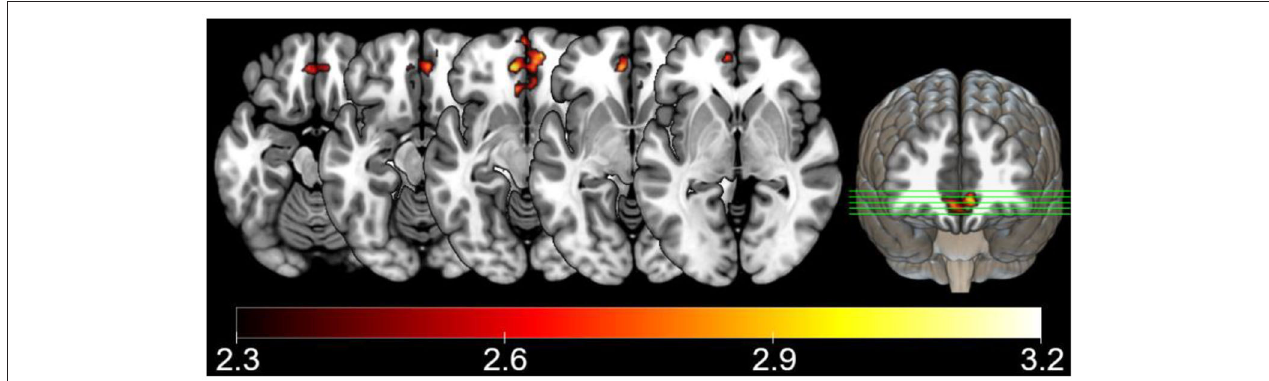
FIGURE 7 | Plots of the semantically related (SR) task block BOLD response (beta-values from first-level GLM analyses) in pre and post-intervention runs in frontal cluster of default-mode network (DMN) found in the ANOVA with stroke patients (SP), showing changes for each subject, in each group. PI, Psychoeducation Intervention; SOST, Semantic Organization Strategy Training; HC, Healthy Controls; SP, Stroke Patients.